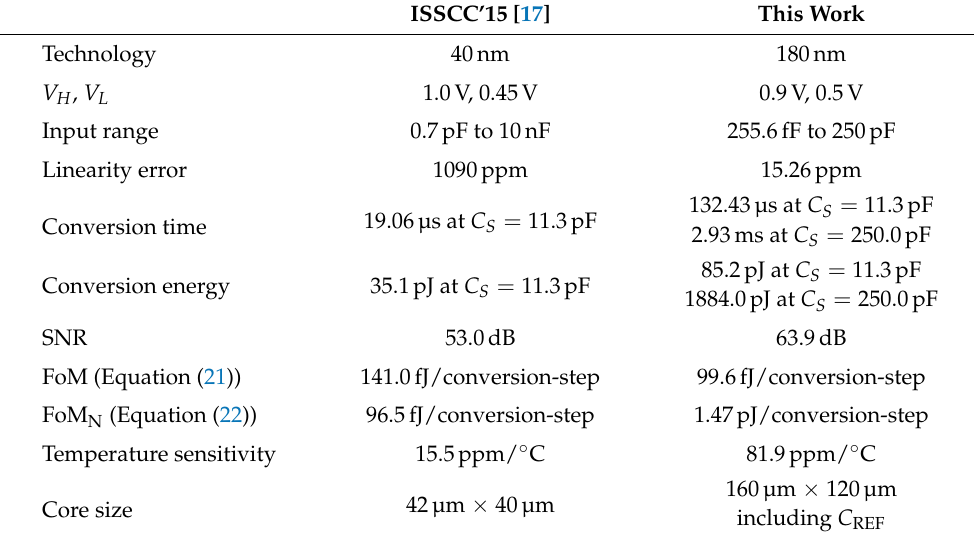
Table 2. Operative conditions and performance comparison table of IDCD